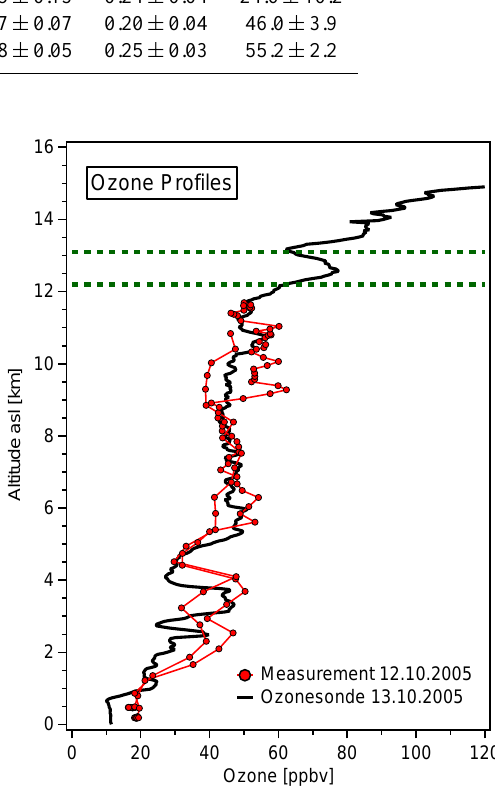
Figure 4. Ozone radio sounding data from the SHADOZ network station in Paramaribo, Suriname. The plot shows vertical profiles including sounding data from 13 October 2005 (black line) and Learjet 35A measurement data from 12 October 2005. The green dotted lines mark the height interval with enhanced O 3 mixing ratios.